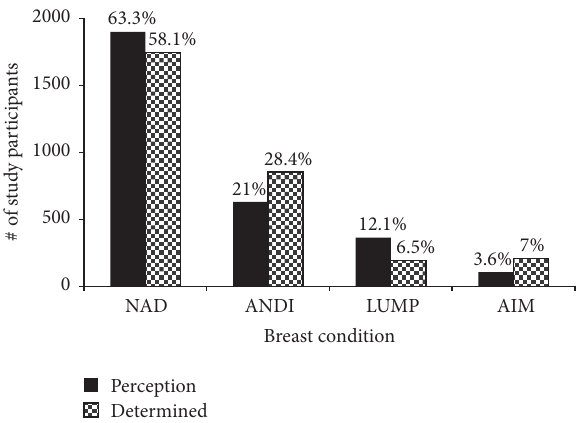
Figure 7: Comparison of perception and determination of breast anomalies among study participants. Participants were asked to examine and report any adverse findings in the breasts (perception) and the results were compared with clinical breast examination by qualified personnel (determined). The differences between the per- ceived and the determined suggest intensification of the campaign message.